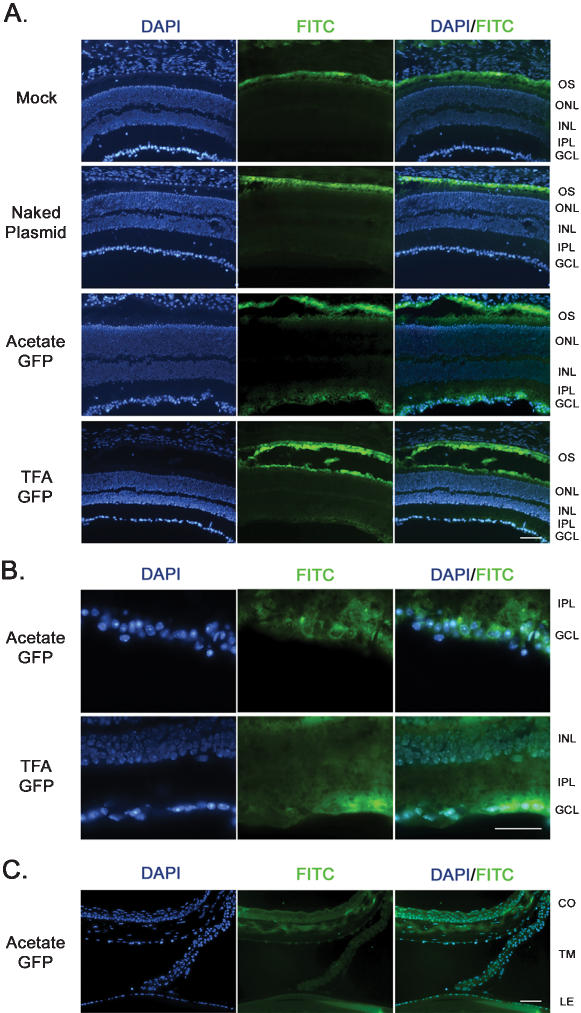
EGFP localization in ocular tissues following intravitreal injection.Direct fluorescence microscopy was utilized to localize EGFP expression in ocular tissues at 2-days post-injection of 0.6 µg of compacted DNA.(A) Retinal autofluorescence was present in the outer segment of all samples including mock- and naked plasmid-injected eyes, however EGFP fluorescence was detected in the GCL of both the AC-GFP and TFA-GFP injected eyes.(B) Upon examination at higher magnification, EGFP expression was confined to the GCL in the AC-GFP-injected eyes, and present in the GCL and IPL of TFA-GFP-injected eyes.(C) Expression of EGFP was also detected in the cornea, trabecular meshwork, and lens following intravitreal injection of both TFA and AC nanoparticles (only AC shown).“FITC” channel imaging was performed as described in the Methods Section.OS: Outer Segment; ONL: Outer Nuclear Layer; INL: Inner Nuclear Layer; IPL: Inner Plexiform Layer; GCL: Ganglion Cell Layer; CO: Cornea; TM: Trabecular Meshwork; LE: Lens.Scale bars, 10 µM.